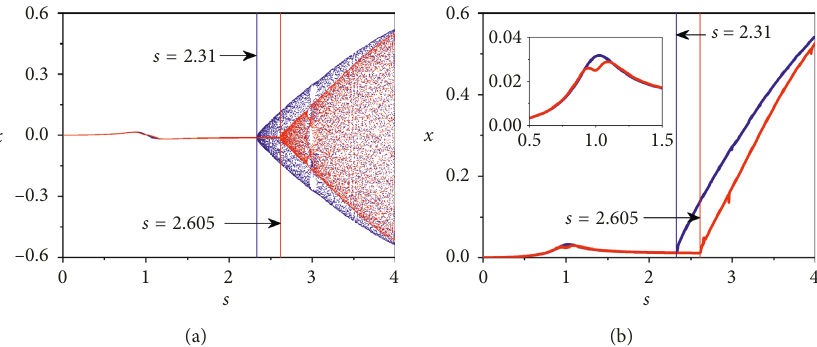
Figure 18: (a) The bifurcation diagram and (b) the amplitude-frequency response curve of the rotor/seal system attached with the DVA in the x coordinate when ζ a 0.06 and σ a 1. (cid:31) (cid:31)